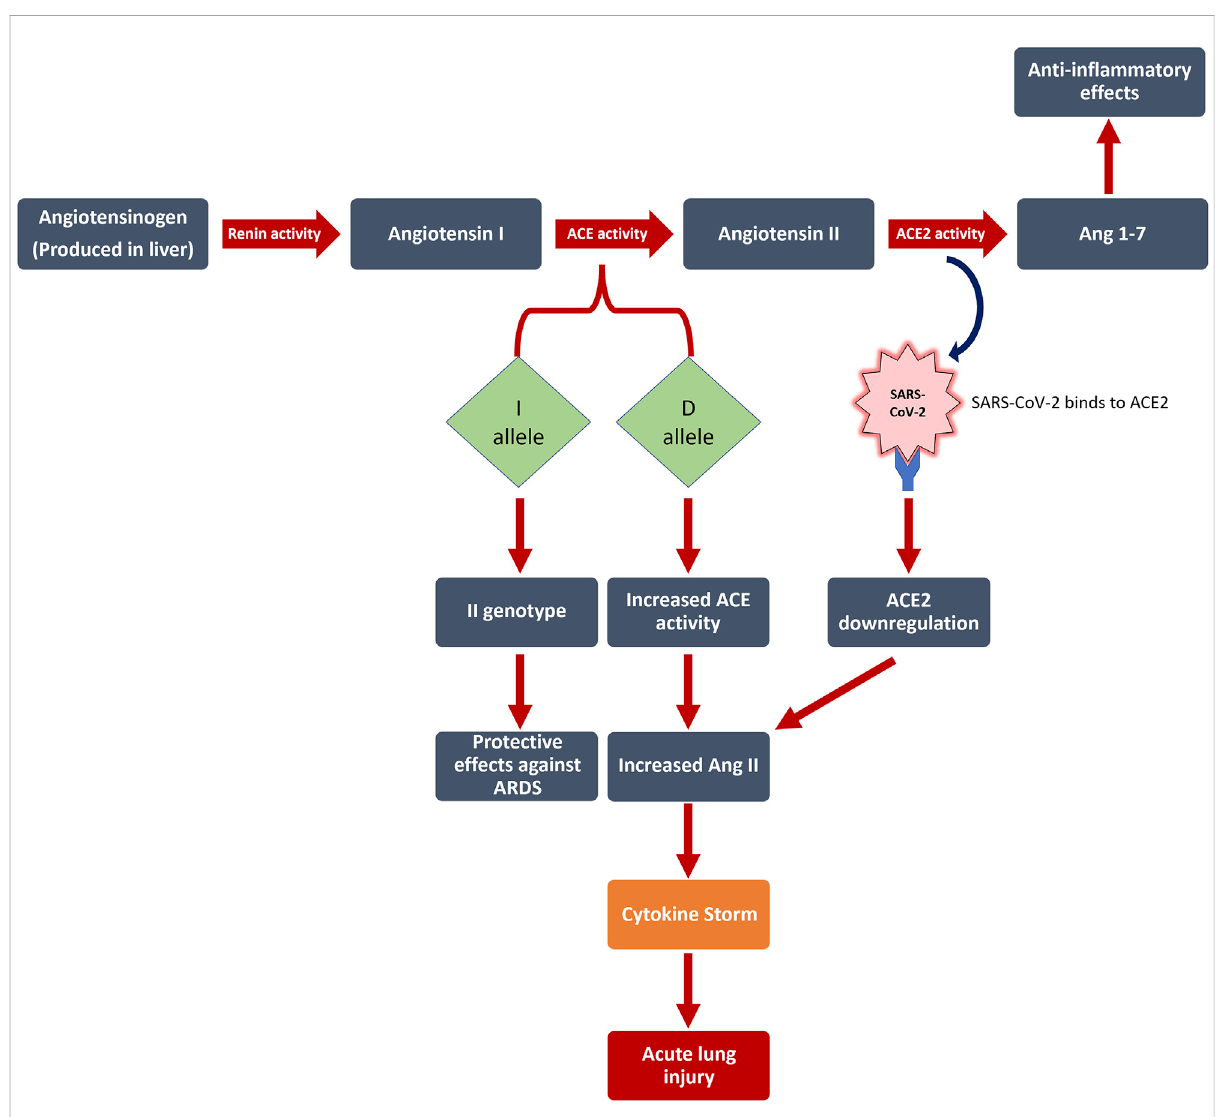
FIGURE 1 TheinterplaybetweenRAS,AngIIlevels,andSARS-CoV-2infectionisillustratedinthis fi gure.Numerouspatientswithnoassociatedriskfactors demonstrate acute respiratory distress syndrome (ARDS). The role of genetic factors in determining the severity and outcome of COVID-19 disease remains unresolved. We discovered that the Angiotensin I Converting Enzyme ( ACE ) insertion/deletion (I/D) polymorphism affects the severity of patients ’ symptoms,withtheDalleleincreasingtheriskofdiseaseseverityby6.8( p =0.012),buthavingnoeffectonmortality.ACE:Angiotensin IConvertingEnzyme; ACE2: Angiotensin-ConvertingEnzyme two; Ang1 – 7: Angiotensin 1 – 7; D allele:Deletion allele;I allele: Insertionallele; ARDS: acute respiratory distress syndrome; SARS-CoV-2: severe acute respiratory syndrome coronavirus